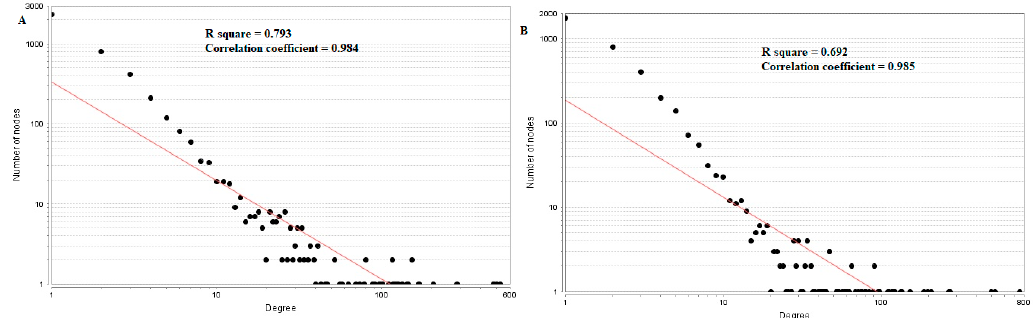
Figure 7. Node degree distribution for up and down regulated genes. Red lines: regression lines. genes (down-regulated) with high betweenness centralitysuch as